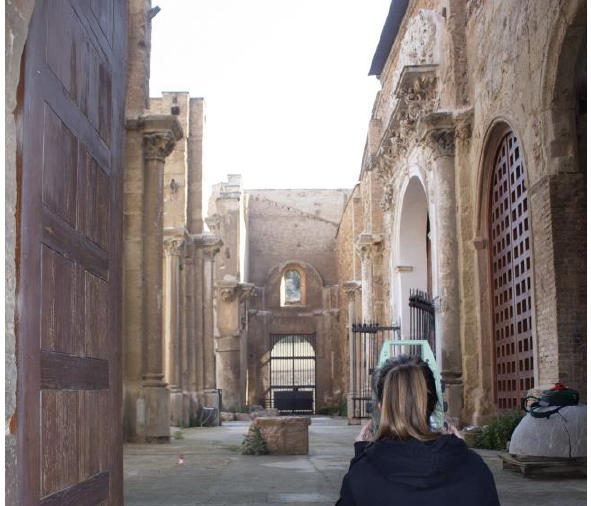
Figure 3. On-site data collection with Leica Nova MS50 multi- station inside the